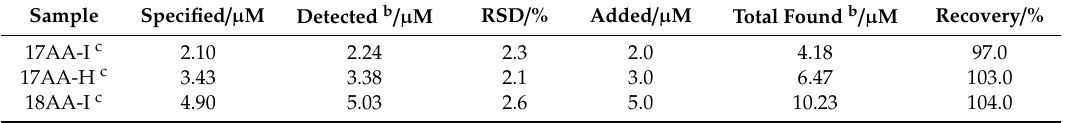
Table 2. Detection of Trp in the compound amino acid injection samples ( n a =